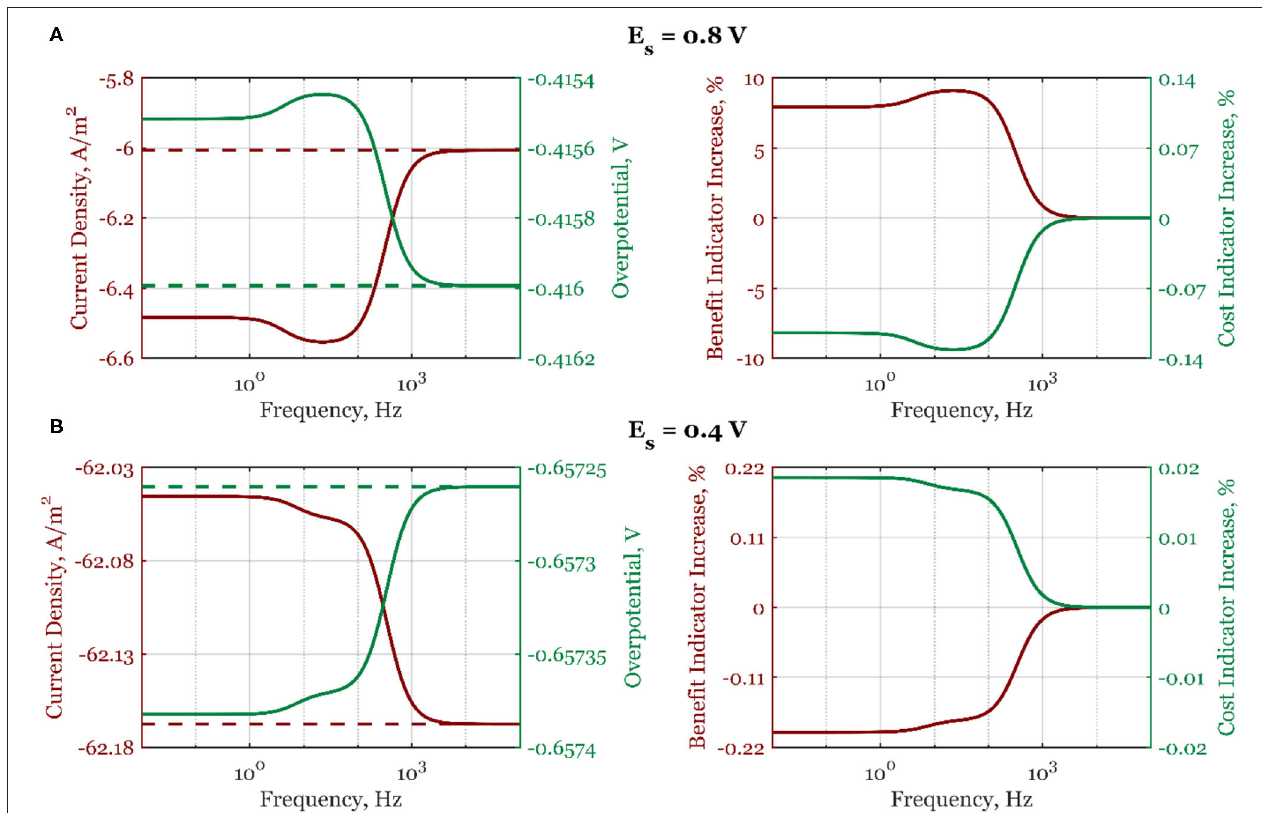
FIGURE 4 | The mean current density and overpotential values (left side) for steady-state (dashed line) and dynamic regime (solid line), and the corresponding dynamic regime benefit and cost indicator increases relative to the steady-state regime (right side) when electrode potential is periodically changed with the amplitude of 5%, steady-state electrode rotation rate ω r , s = 2,500 rpm, and electrode potentials: (A) E s = 0.8V and (B) E s = 0.4V, in the frequency range of 10 − 2 -10 5 Hz.